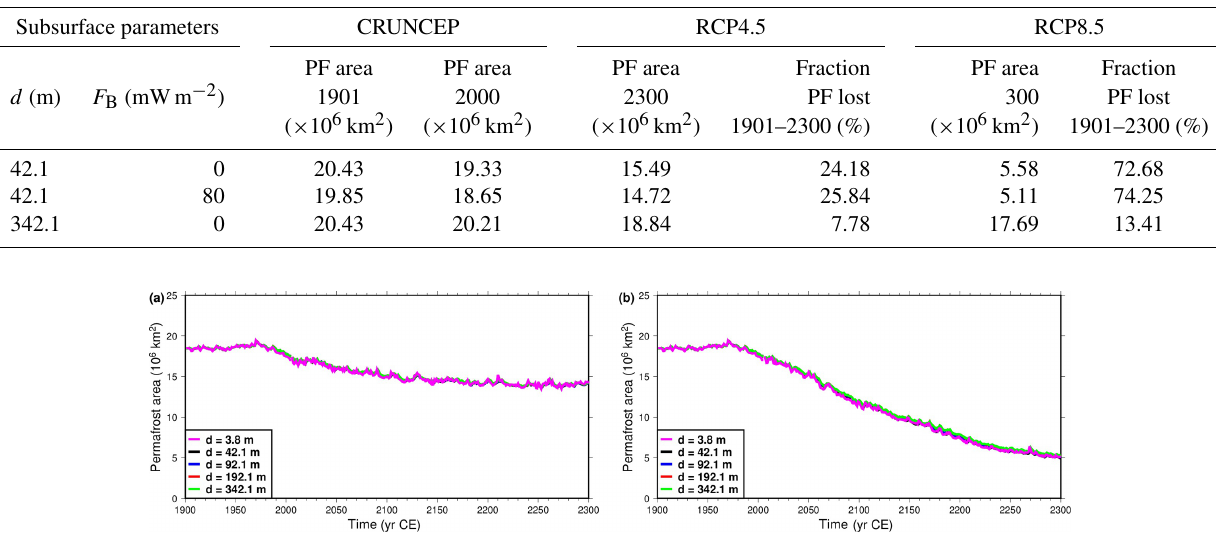
Figure 10. Northern Hemisphere near-surface permafrost area as function of time. Model versions with bottom boundary depth at 3.8m (magenta), 42.1m (black), 92.1m (blue), 192.1m (red) and 342.1m (green). (a) Simulations forced with CRUNCEP + RCP4.5 data. (b) Sim- ulations forced with CRUNCEP + RCP8.5